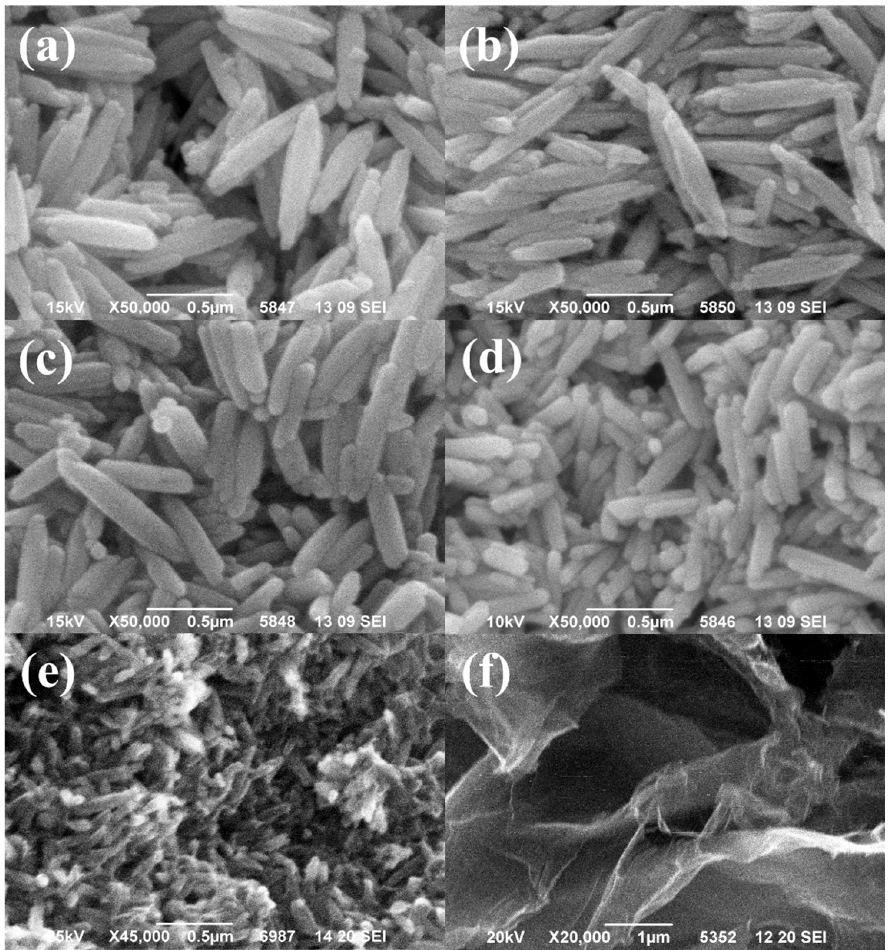
Figure 5. Scanning electron microscopy (SEM) image of samples. ( a ) Eu(OH) 3 /RGO 130, ( b )